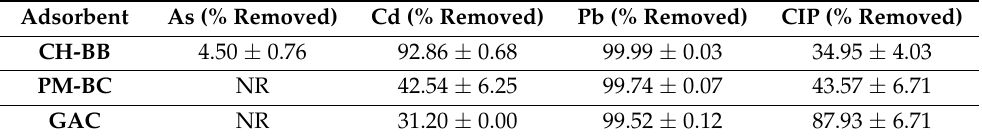
Table 5. Comparison of removal efficiency between different